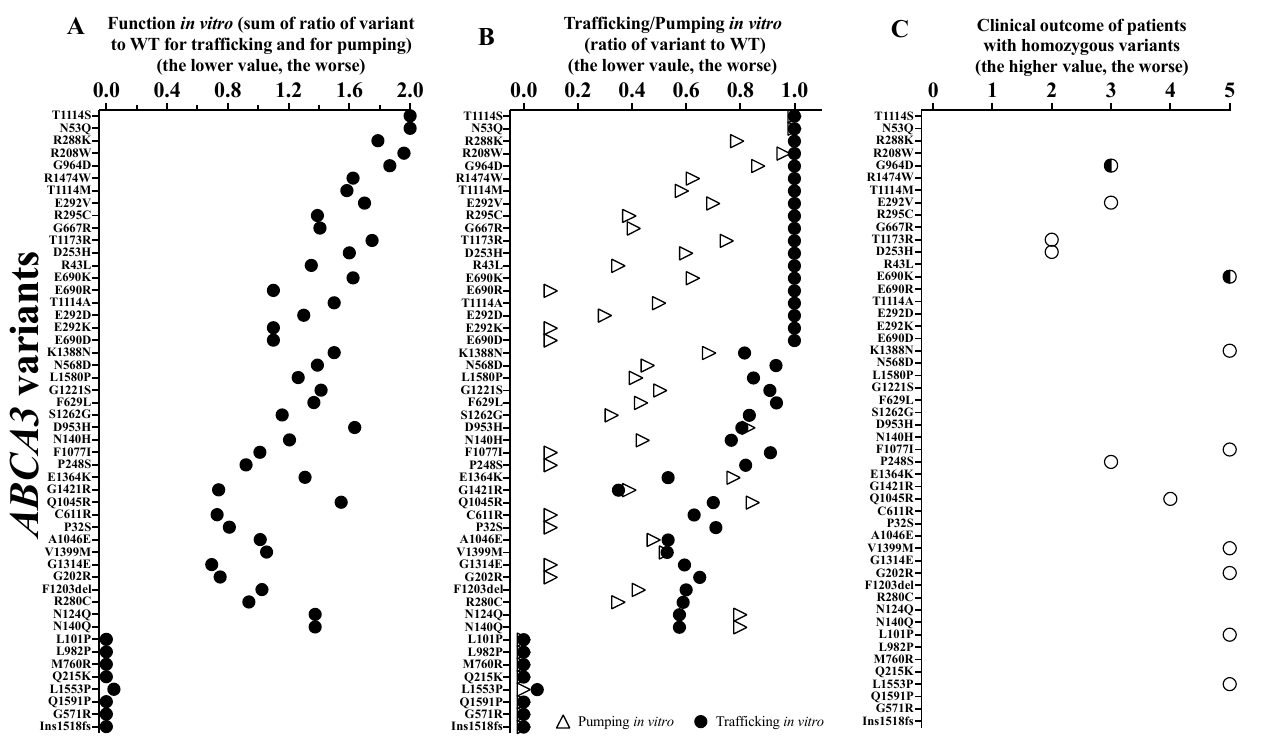
Figure 5. ( A ) Function in vitro; ( B ) trafficking/pumping of ABCA3 variants; ( C ) clinical outcome of patients with homozygous ABCA3 variants. Hollow circles stand for the clinical outcomes of patients with homozygous variants. The semi-hollow circles stand for the clinical outcomes of patients with homozygous variants and with lung transplantation.